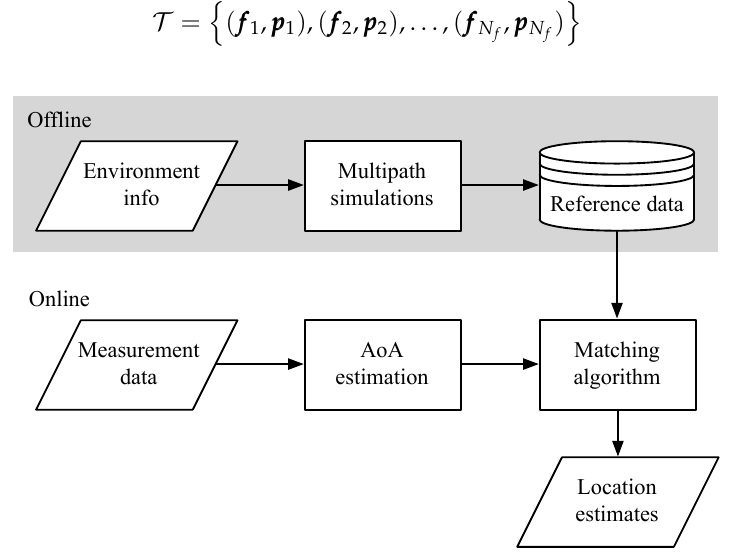
Figure 1. Architecture of the localization process with a single anchor